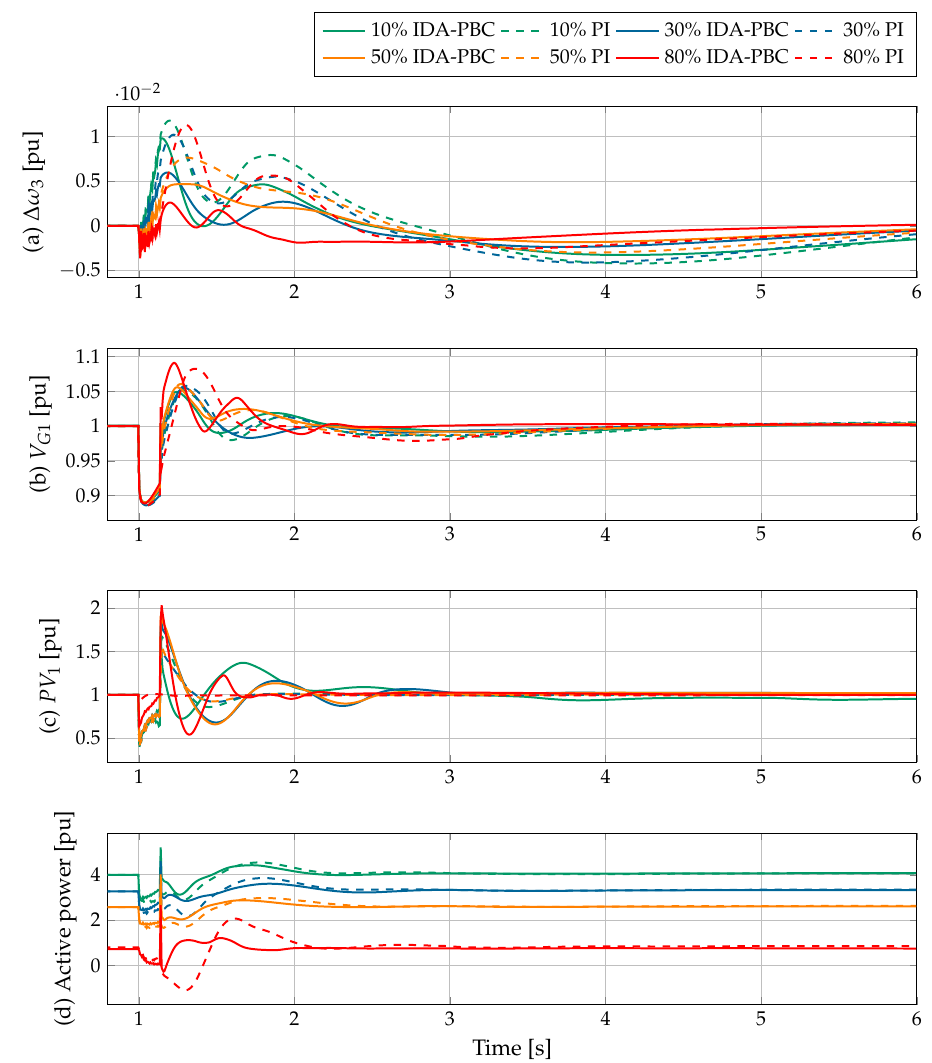
Figure 8. Response of the test system to a short circuit on bus 8 for 140 ms: ( a ) rotor speed deviation of generator 3, ( b ) terminal voltage of generator 1, ( c ) active power of PV plant 1, and ( d ) active power of generator